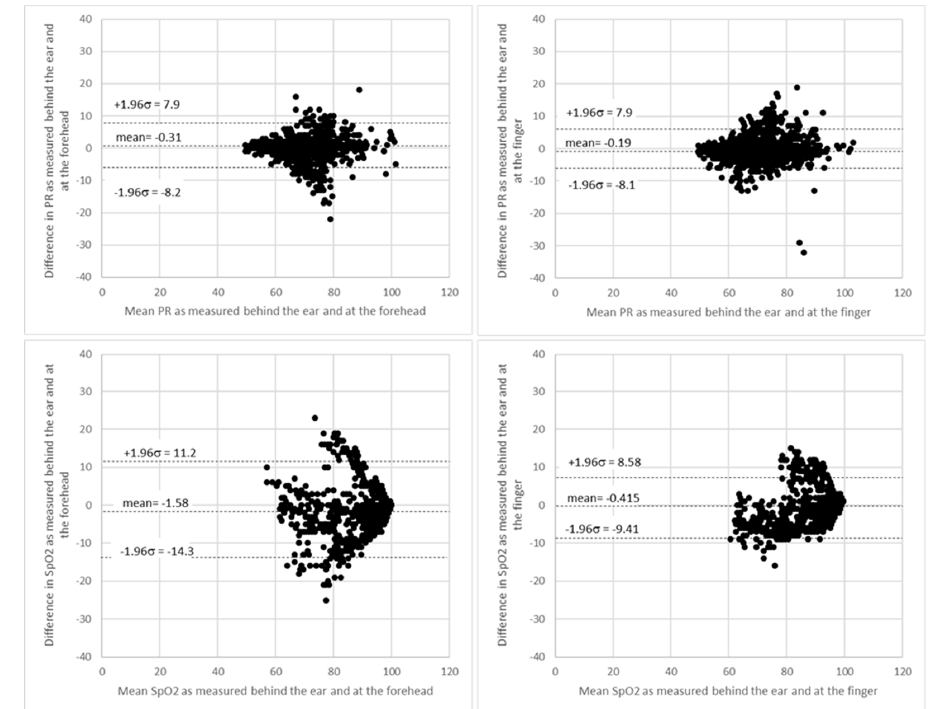
Figure 5. Bland–Altman plots of PR and SpO 2 measurements comparing SPYDR with finger and forehead PPG. The x and y axes indicate the mean and difference of the photoplethysmography (PPG)-derived and the corresponding reference respiratory frequencies, respectively. The dotted lines show the mean bias. The limits of agreement (LoA) mean ±1.96 SD interval of difference are given with the solid lines.